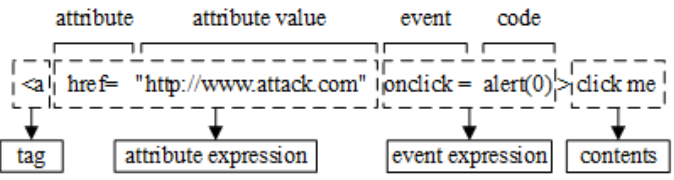
Figure 3. XSS attack vector structure